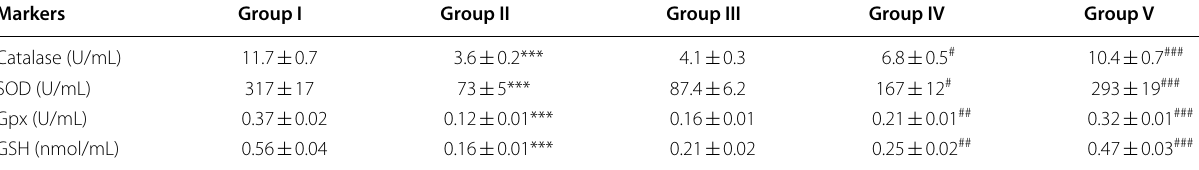
Table 1 Effect of catalpol supplementation on antioxidant markers in cardiac arrhythmia-induced pluripotent stem